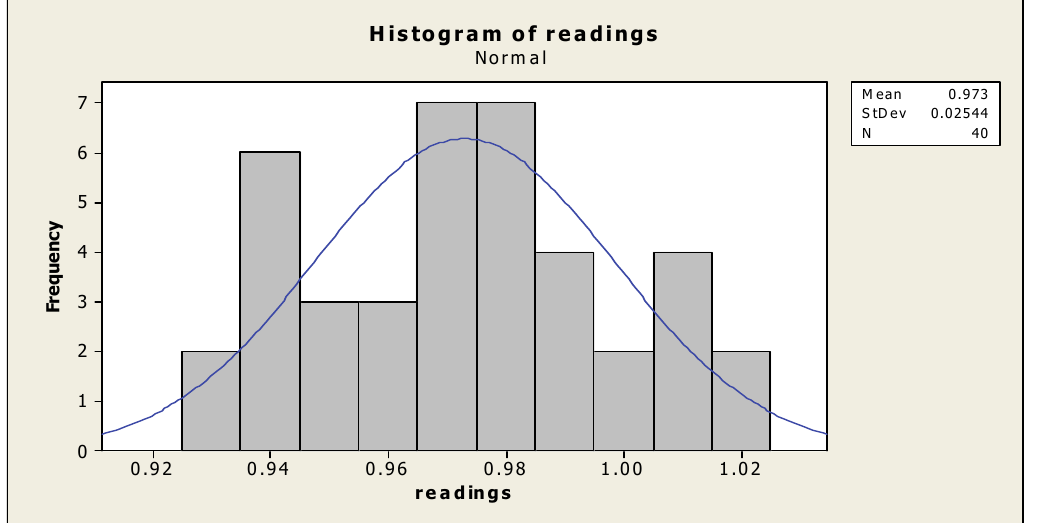
Fig. 6. Histogram for Spring Diameter